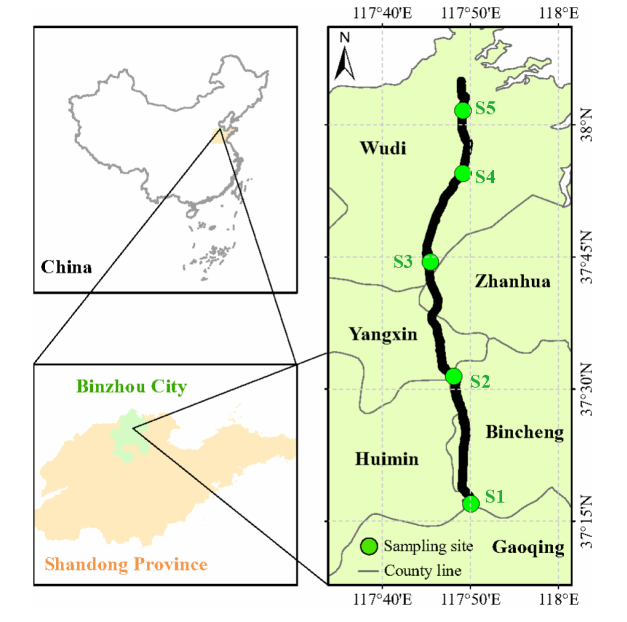
FIGURE 1 The location of the study area and distribution of sampling sites. S1, very low salinity; S2, low salinity; S3, medium salinity; S4, high salinity; S5, very high